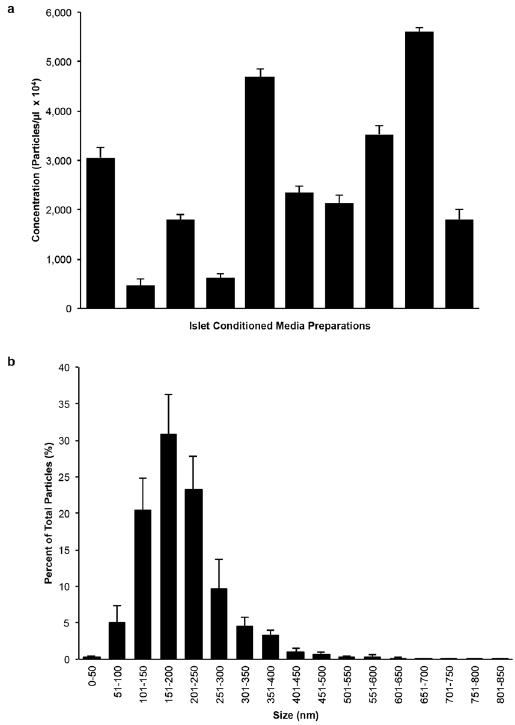
Figure 2. Cultured human islets produce distinct populations of particles. ( a ) Nanoparticle tracking analysis (NTA) graph of mean particle levels in ICM from ten donors (n = 10) shows variable levels between preparations. ( b ) NTA histogram of particle size distribution shows the majority of particles detected are between 100 nm and 650 nm. Data are expressed as mean ± SEM of ten donors (n = 10). At least 5 recordings, 30 seconds each were obtained for each sample at 37 °C, camera shutter speed of 30.0 ms, camera level 14 and detection threshold set to